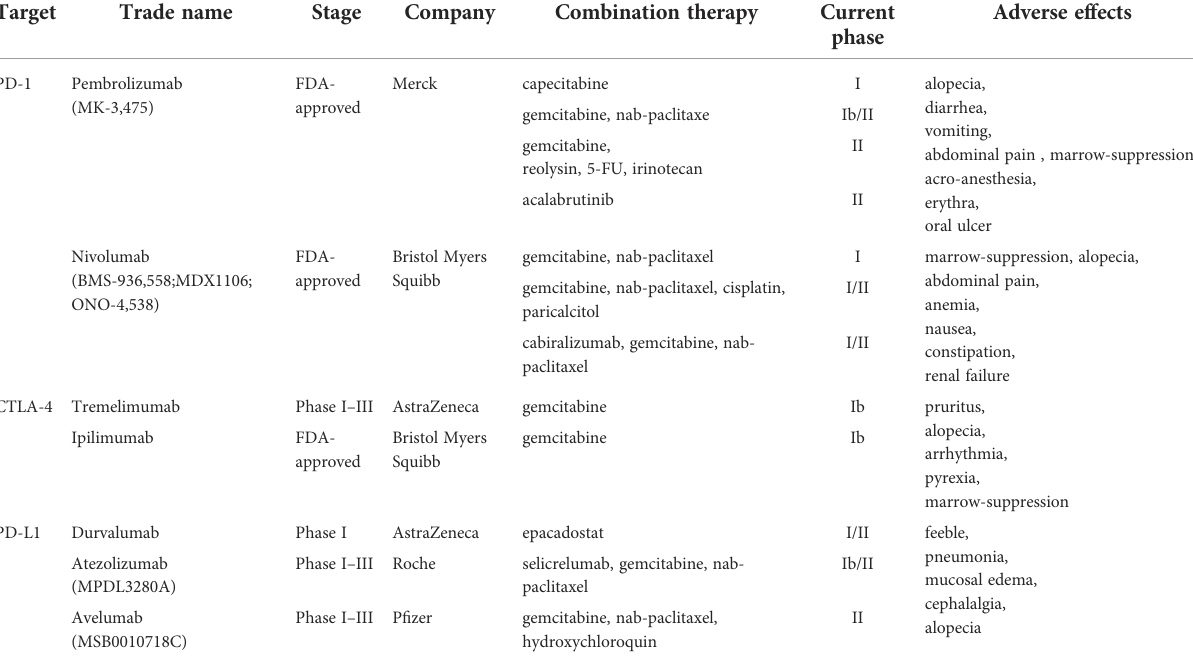
TABLE 1 Immune checkpoint inhibitors in combination with other therapies currently used in the clinical test medication.